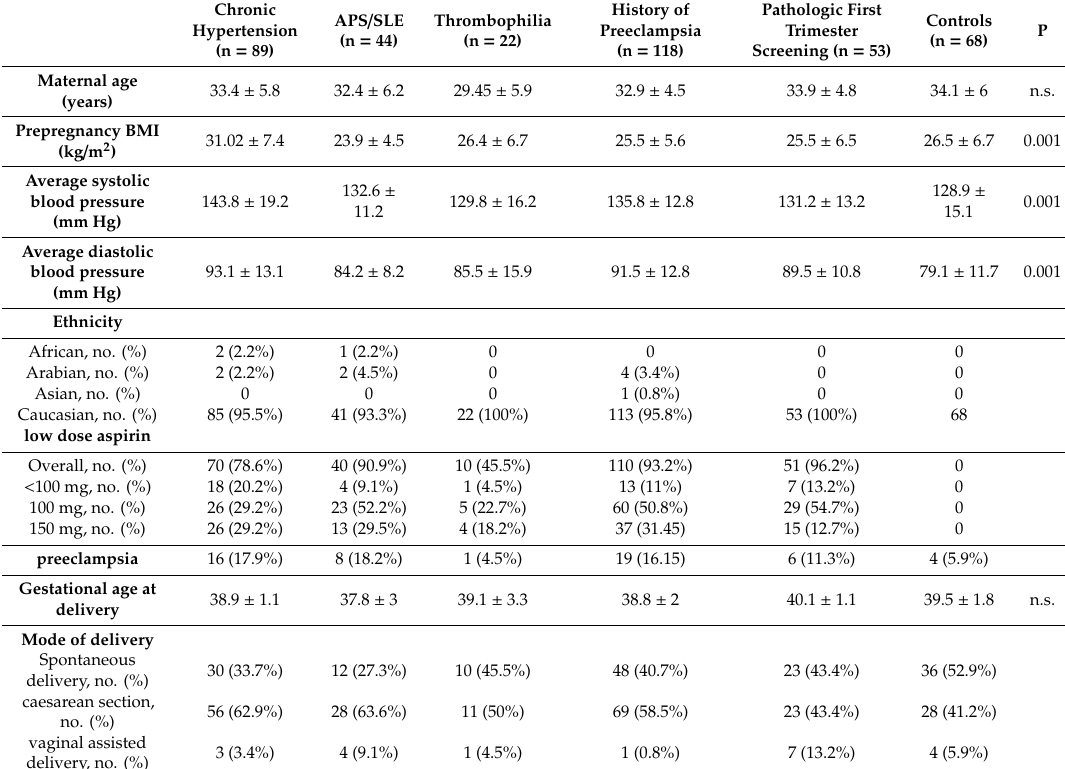
Table 1. Demographic characteristics of women included in the